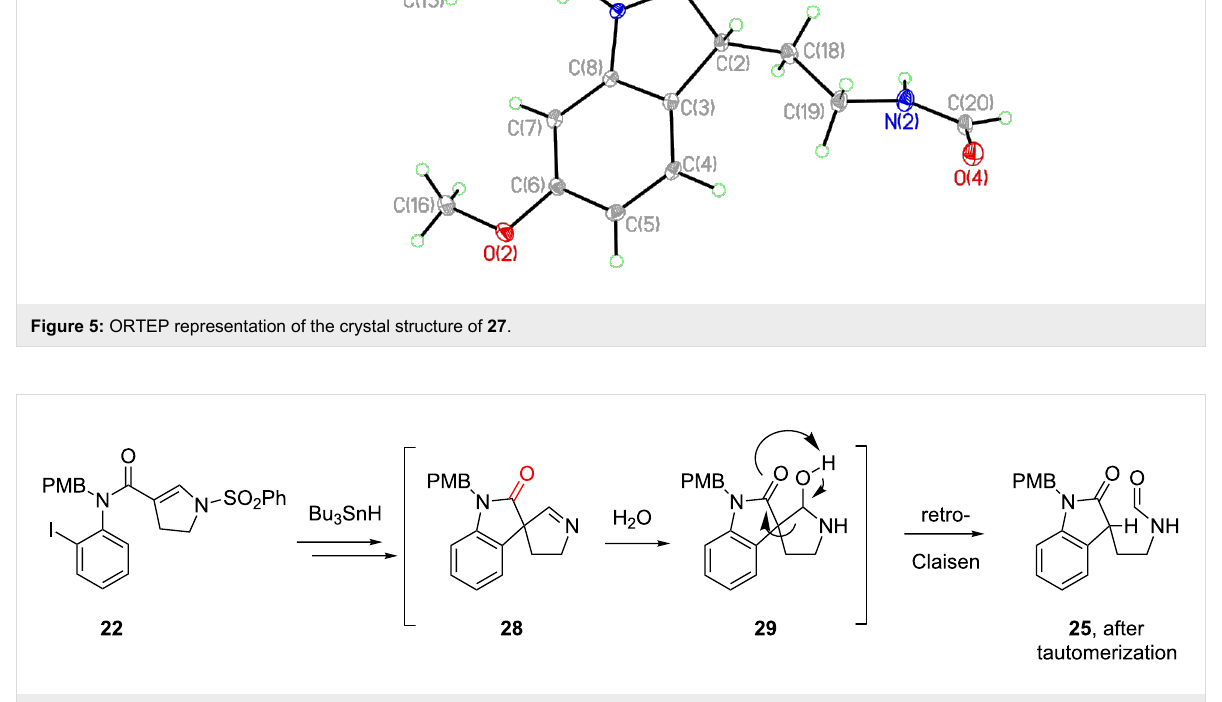
Figure 6: Proposed hydration/retro-Claisen path to